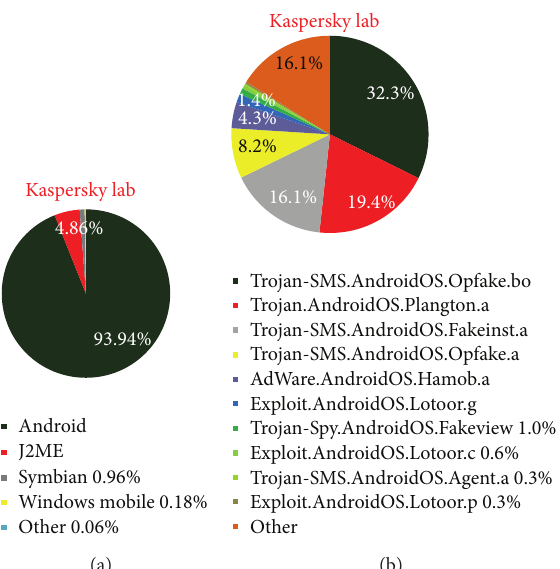
Figure 1: (a) Distribution of mobile threats by platform, 2004–2012; (b) the most frequently detected malicious programs targeting android.